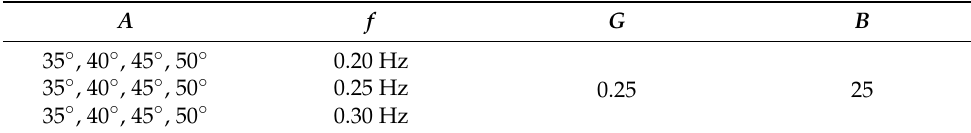
Table 4. High-level control command in instant mode.